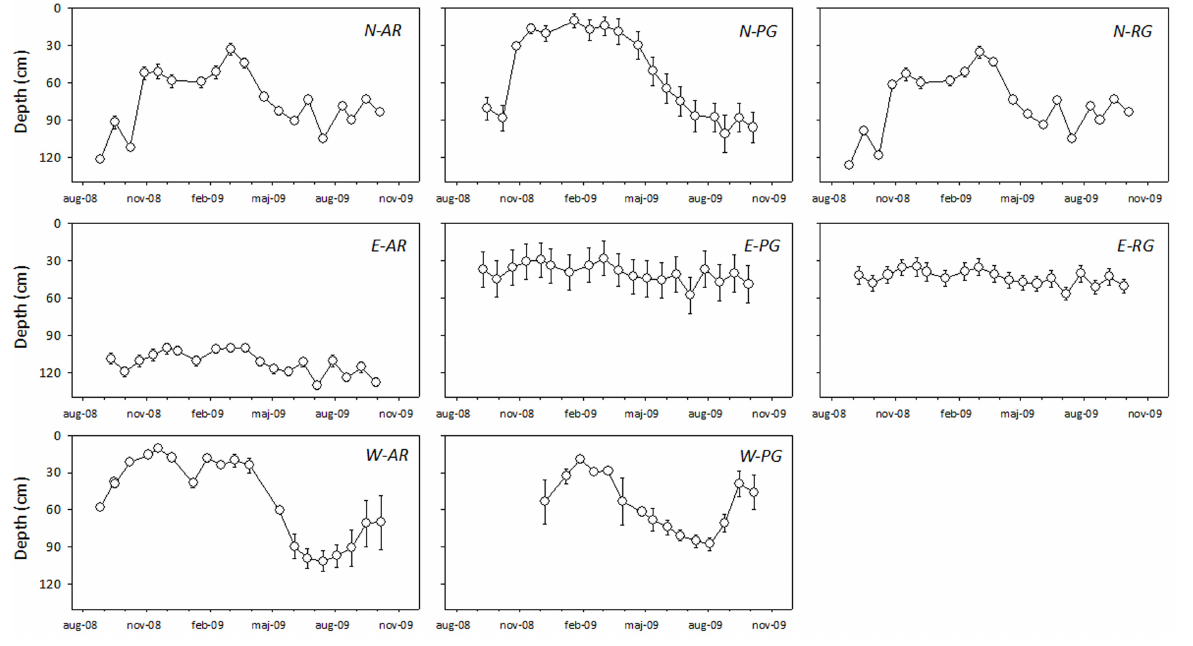
Fig. 3. Seasonal variations in groundwater level (GWL) at the eight monitoring sites; for information about site ID, see legend to Fig. 2. The data (mean ± standard error) represent GWL in piezometers at the paired sampling points during gas flux measurement campaigns ( n = 3).